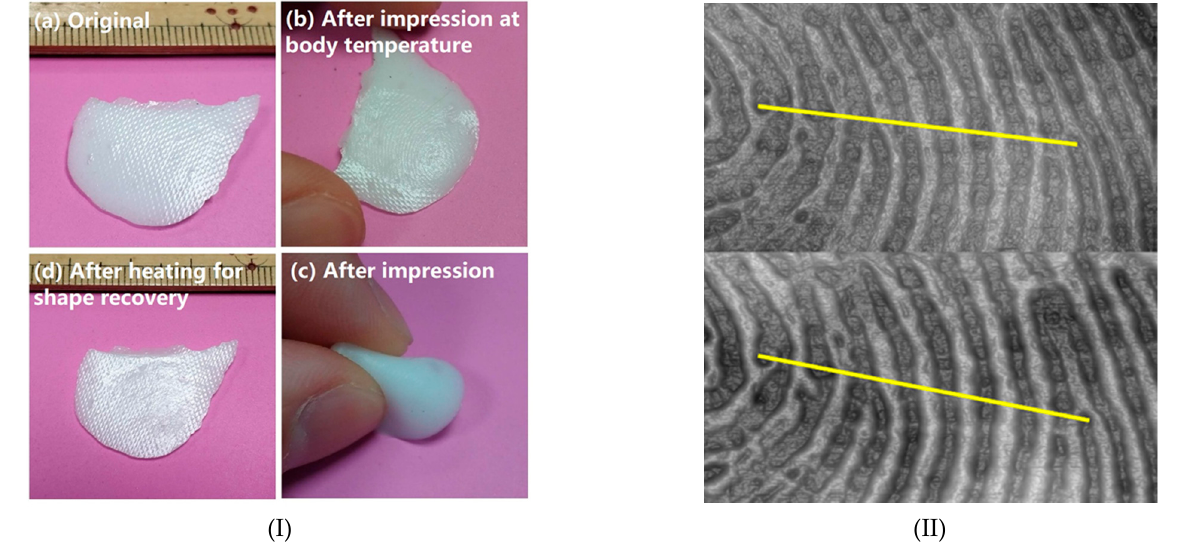
Figure 16. Fingerprint capture in a solid SMH (60:40 of silicone:PCL) ( I ); and comparison with wax ( II ) (top: silicone/PCL; bottom: wax).